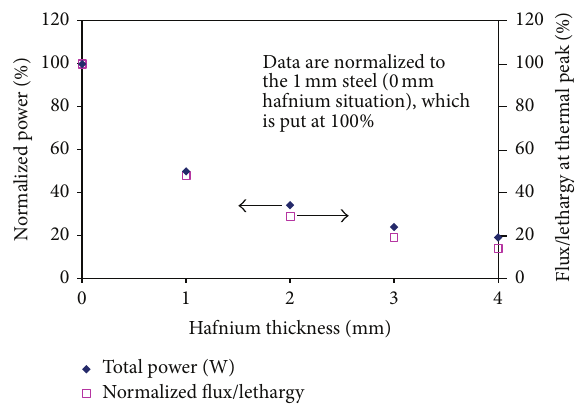
Figure 13: The normalized power density and the normalized flux per unit lethargy at the thermal peak plotted as a function of the Hf thickness